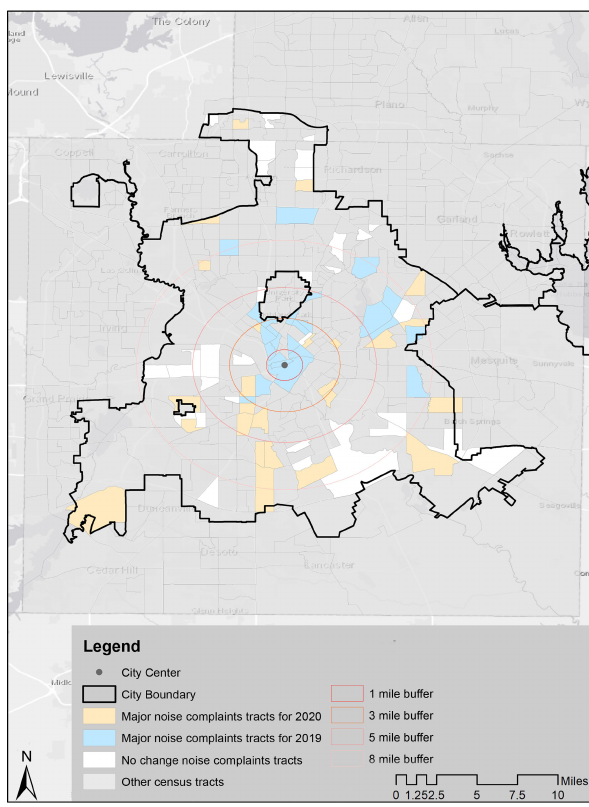
Figure 3: Census tracts with major noise complaints before the COVID-19 and during the COVID-19